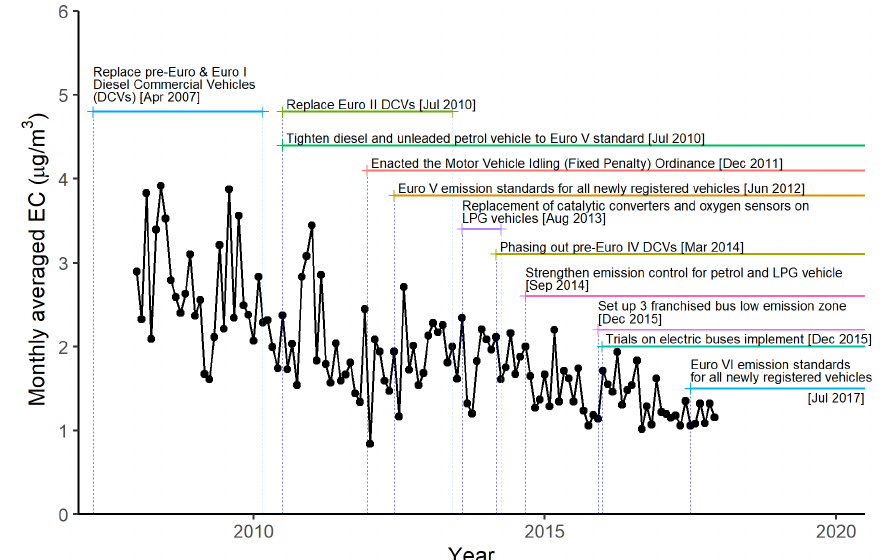
Figure 8. The 10-year variation of monthly EC concentration. The significant vehicular emission control measures implemented in Hong Kong are indicated in the